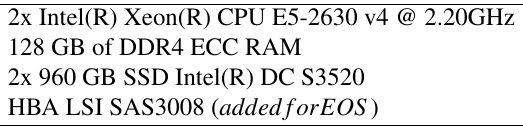
Table 2. Typical EOS server